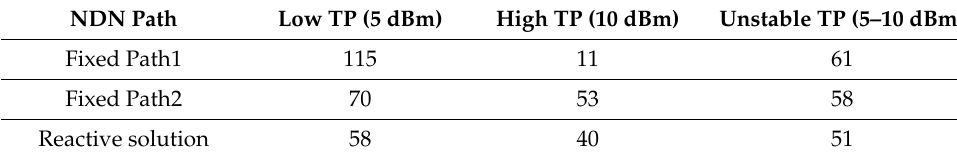
Table 3. Total amount of failures over 1500 interest-data exchanges.